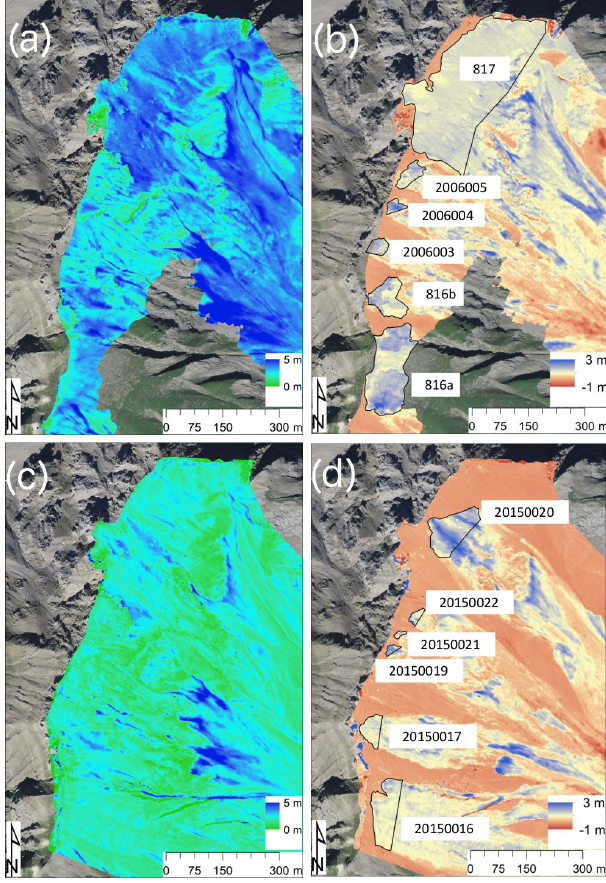
Figure 6. Snow depth before avalanche release on (a) 8 March 2006 and (c) 3 February 2015. Difference of snow depth before and after artificial avalanche release obtained from the scans of (b) 8 March 2006 and (d) 3 February 2015. The release zones and their avalanche tracks are clearly visible. Further, release area num- bers according to Table 3 are also